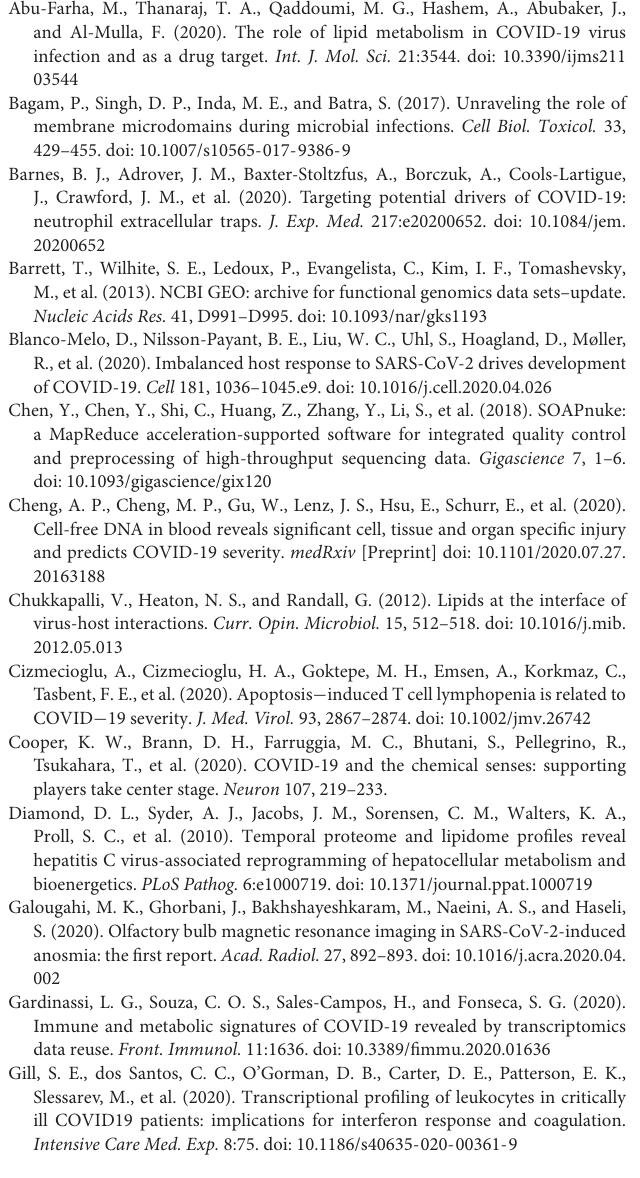
pattern (D) in plasma of severe patient and lung cells of SARS-CoV-2 infection. Supplementary Table 1 | Genes with significantly different TSS coverage profiles in severe COVID-19 patient compared with mild patient. Supplementary Table 2 | Genes with significantly different expression levels in blood cells of COVID-19 patient and lung cells with SARS-CoV-2 infection compared with COVID-19-negative cases showed consistently altered pattern in plasma of our severe patient. Supplementary Table 3 | Microbiomes infected in plasma of cases and controls. Supplementary Table 4 | Clinical laboratory records of the mild and severe